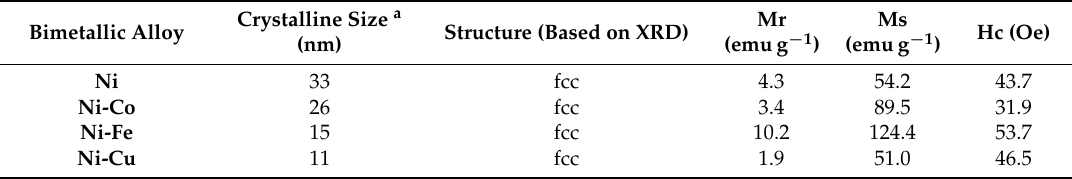
Table 3. The remanence (Mr), saturation magnetization (Ms), and coercivity (Hc) magnetic parameters of the